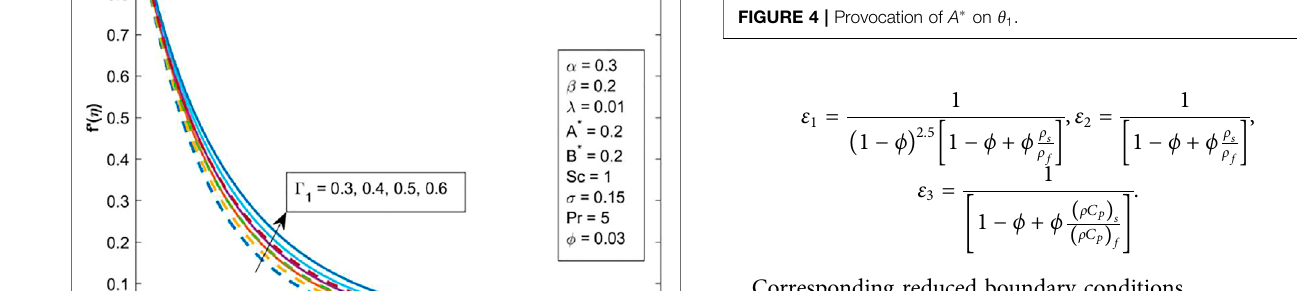
FIGURE 4 | Provocation of A p on θ 1